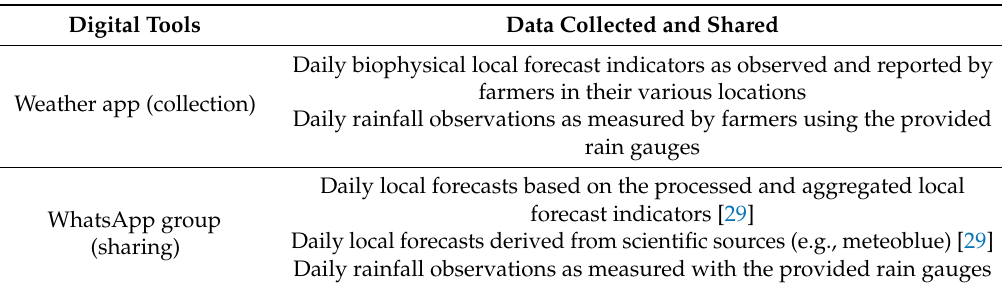
Table 1. Data collected and shared via the digital tools.